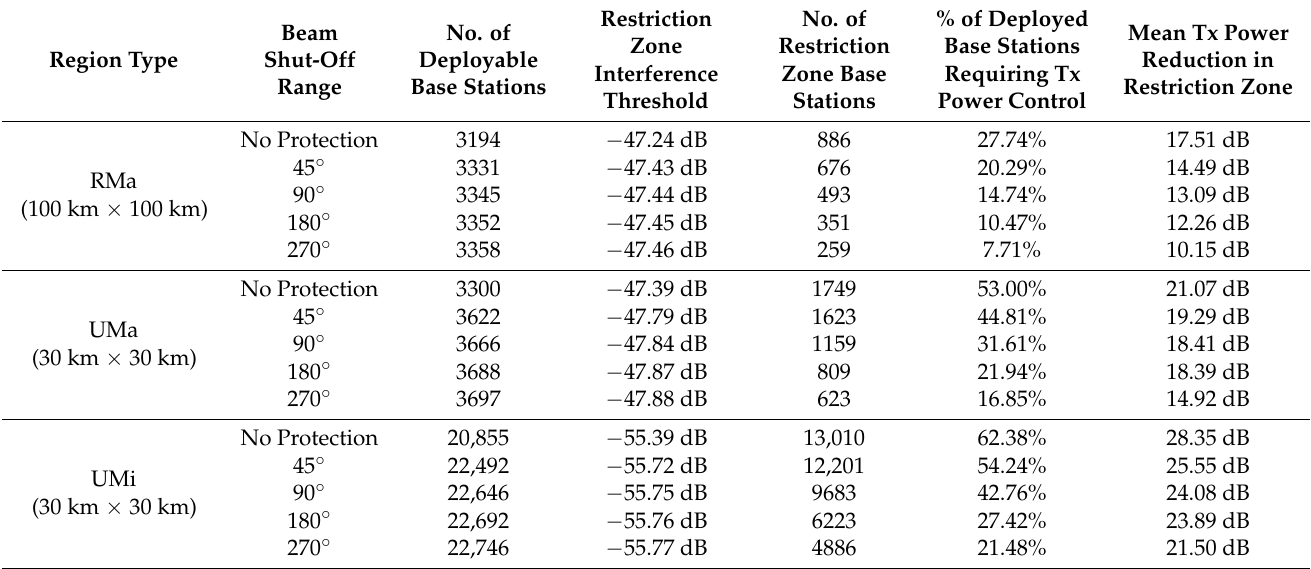
Table 5. Mean transmission (Tx) power reduction in the restriction zone for RMa, UMa, and UMi using a 16 × 16 antenna